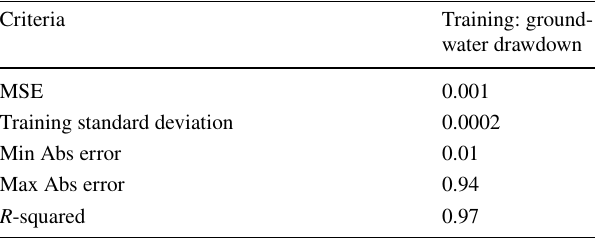
Table 2 Correlation coefficients between the input variables and groundwater depth drawdown